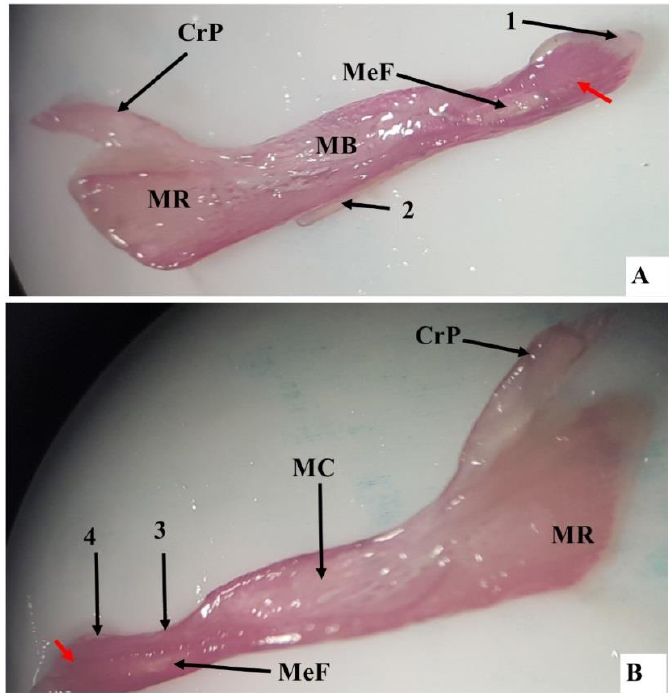
Figure 2. A stereomicrograph of the lateral (A) and dorsomedial view (B) of a 42 nd day-old Yankasa mandible, ossification centres (red arrow) showing mental foramen (MeF) and Meckel’s cartilage on the body (2) and cartilaginous alveoli, mandibular body, mandibular rami, and coronoid process (1, MB, MR, CrP respectively), the mandibular incisure (3), lingual surface (4), and the mandibular canal (MC), Alizarin red stain (X5).